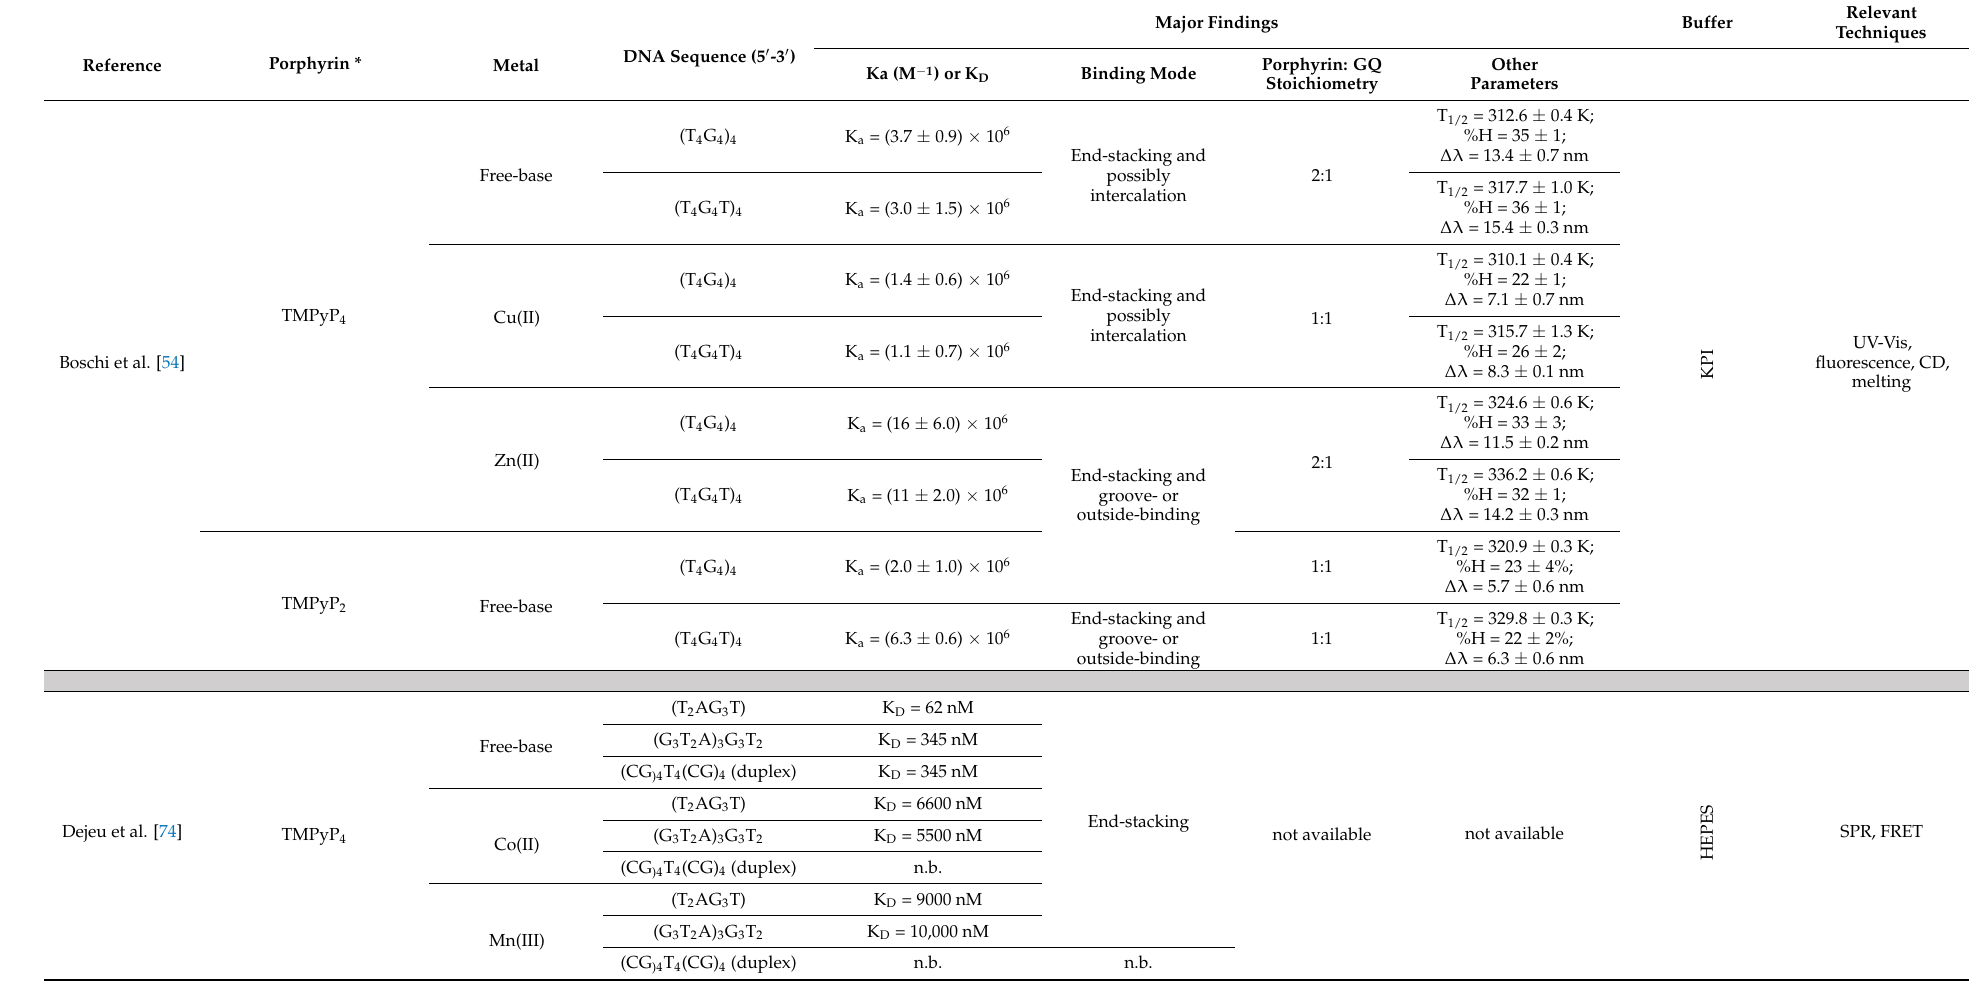
Table 1. Compilation of results obtained for the MTMPyP and analogues (vide infra Figure 14) by different selected authors (organized by alphabetic order), using different methodologies.